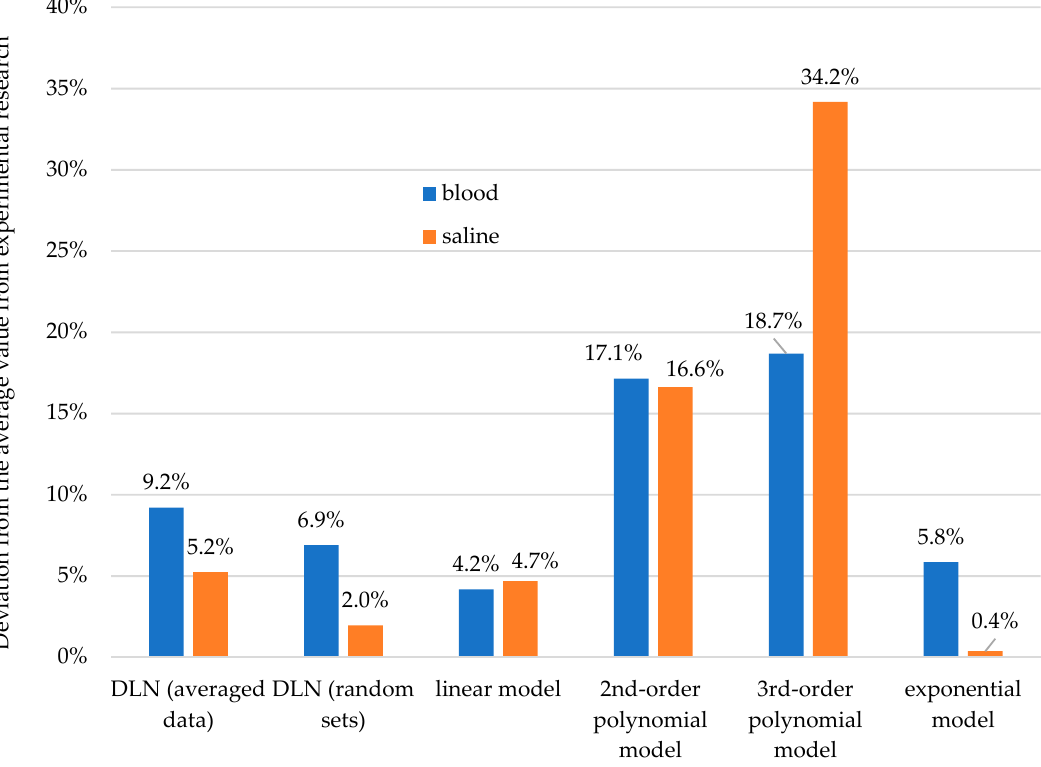
Figure 9. Uncertainty of prediction of strength at 8% contamination based on data from the 0–6% range.